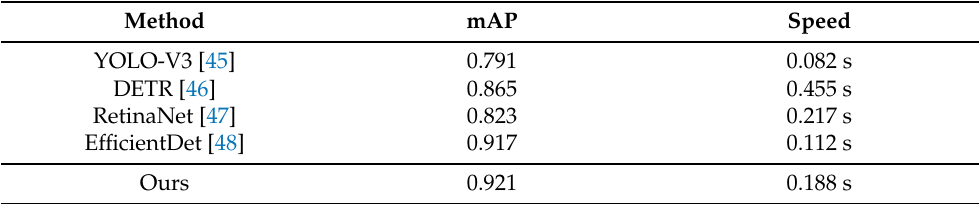
Table 1. The performance of different object detection methods in our